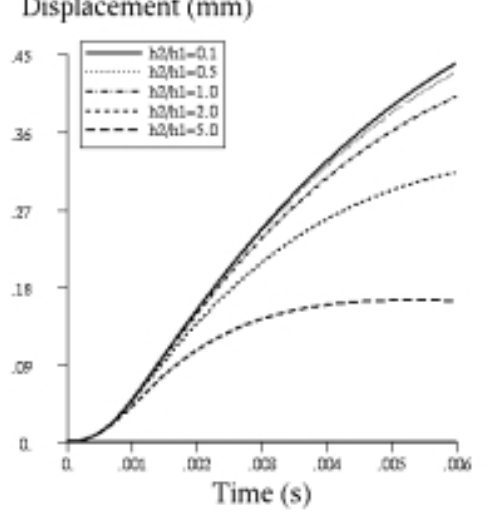
Fig. 5. Variation of central velocity with time for different thickness